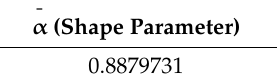
Table A21. MNIG Shape parameter α for Vector 6: Urals, Marlim, RTSI, IBOV. ¯ α (Shape Parameter)